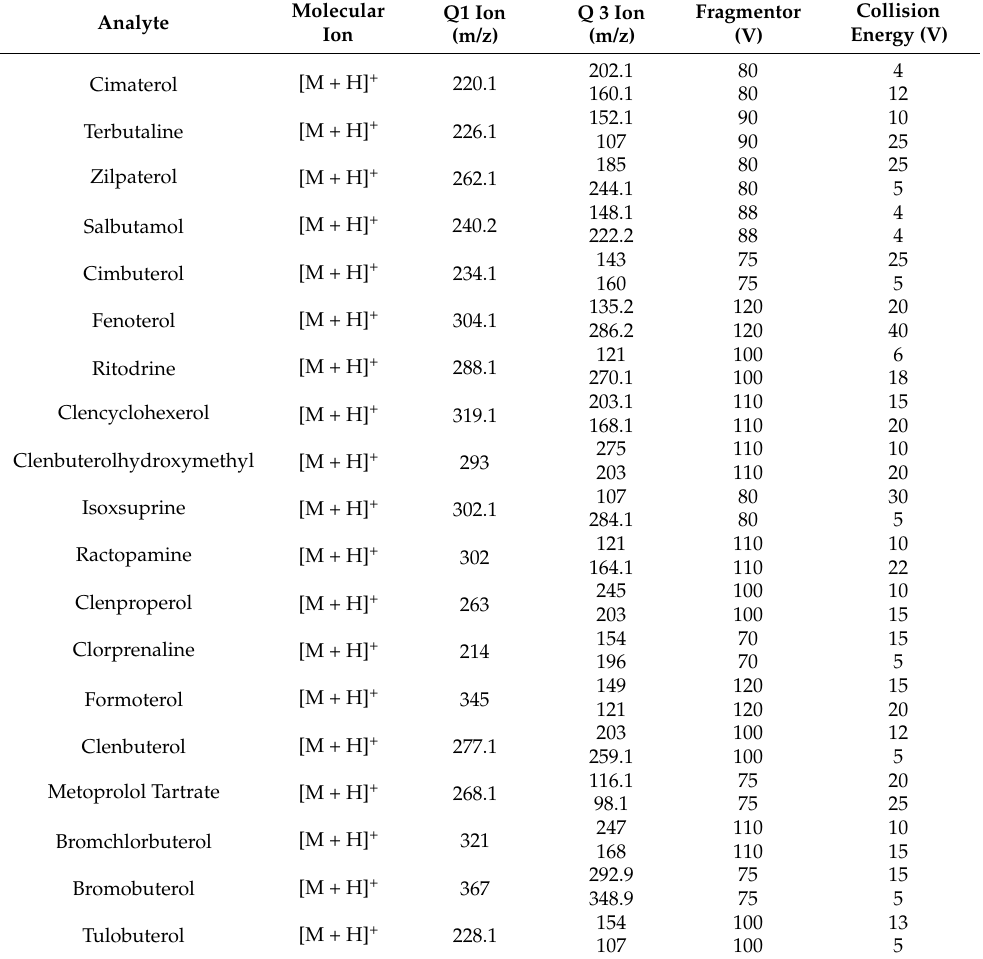
Table 1. Retention time and m/z of targeted analytes and their related MRM